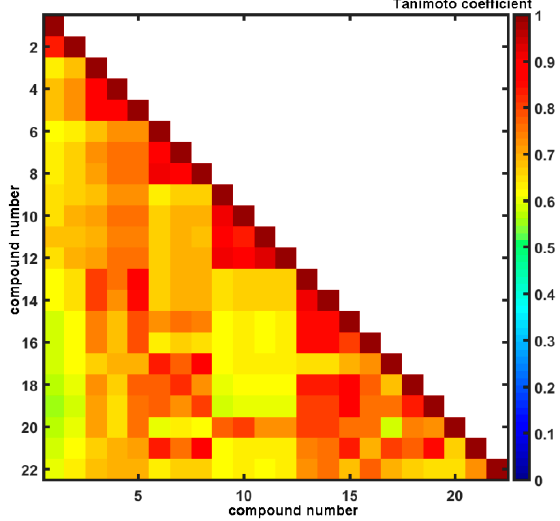
Figure 3. Triangular matrix of Tanimoto coefficients for 1 – 22 carboxamides.